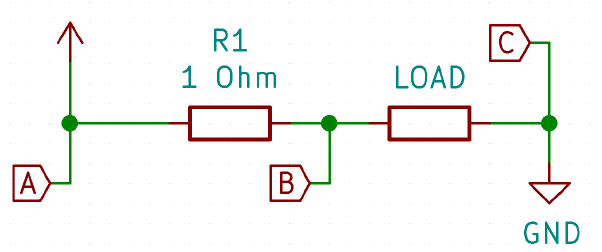
Figure 9. Current used measurement model